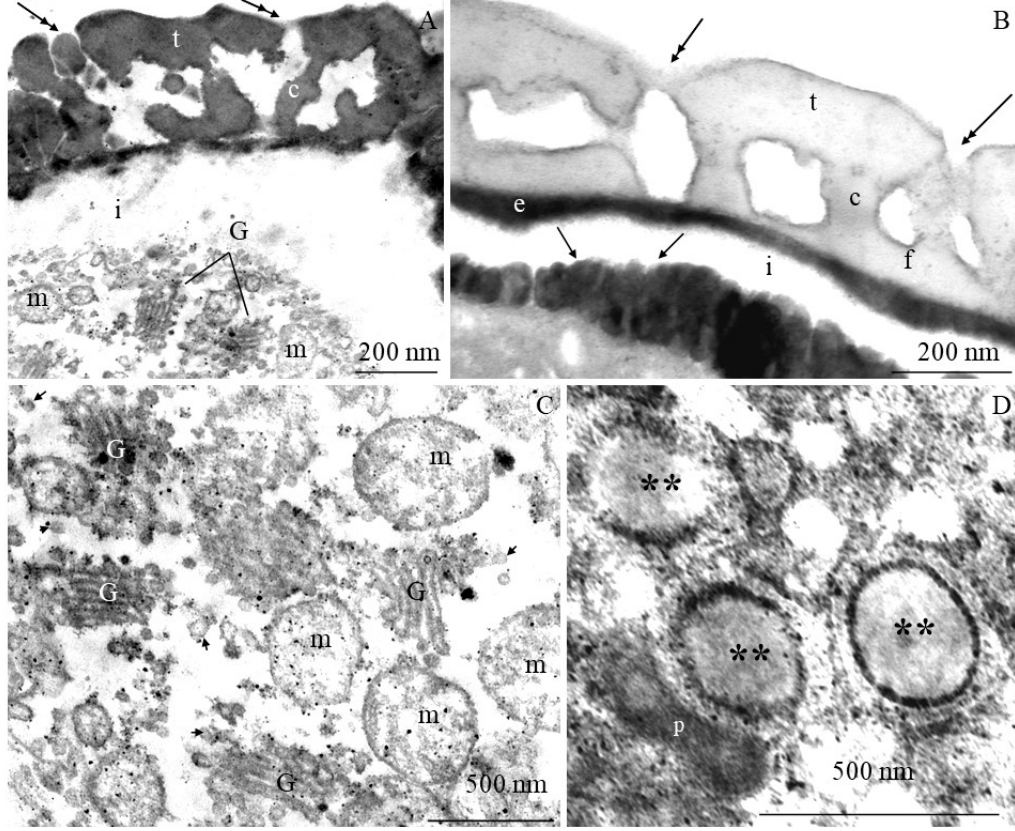
Figure 9. A – G . Fragments of pollen grains in R. idaeus ‘Radziejowa’: ( A , B) —tectum (t) with perforations (double-headed arrow), columellae (c), foot layer (f), endoexine (e), Golgi apparatus (G) and a mitochondrion (m), e electron-dense structures (arrows) located at the intine (i); ( C )—numerous mitochondria (m) and Golgi apparatus (G), dictyosomal vesicles (arrowheads); ( D )—plastoglobules (two asterisks), plastids (p). A – D - TEM.